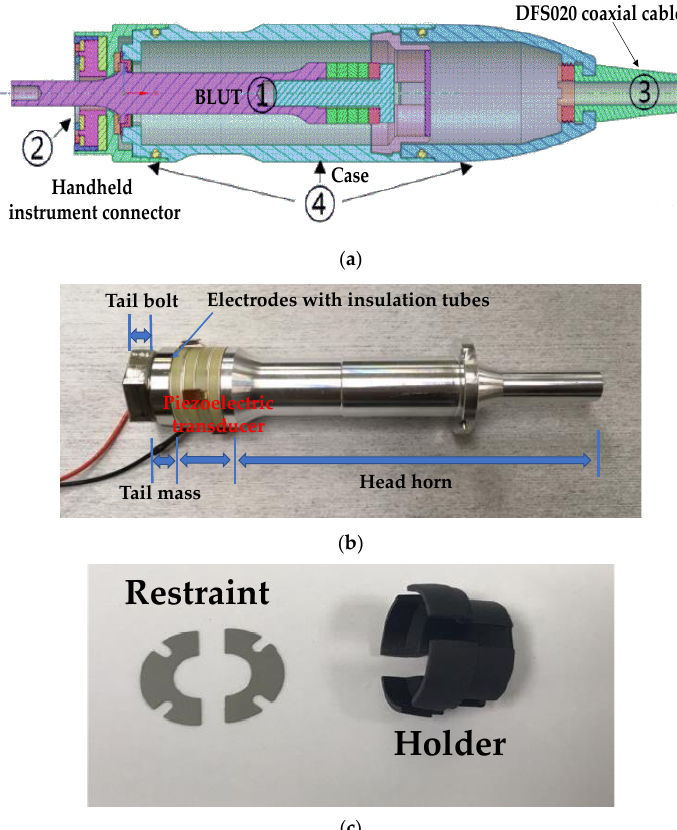
Figure 2. ( a ) Modeled handpiece. ( b ) Handpiece with BLUT. ( c ) Restraint and holder components.